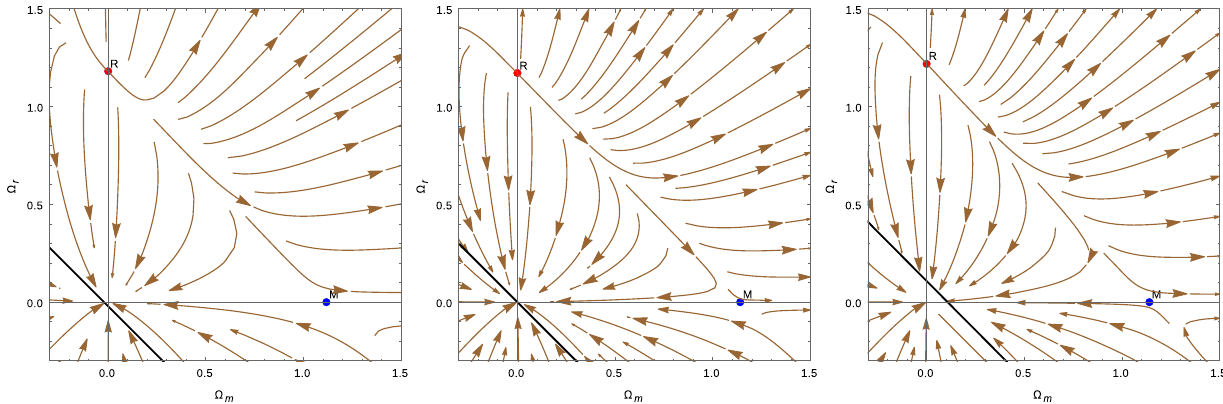
Fig. 5 Thephasespaceportraitofthedynamicalsystem(43) and(44). Wehave plottedthe ((cid:14) m ,(cid:14) r ) planesforthreedifferent values of η = − 0 . 02 (left), η = 0 (center) and η = 0 . 1 (right). The corresponding fixed points are also shown